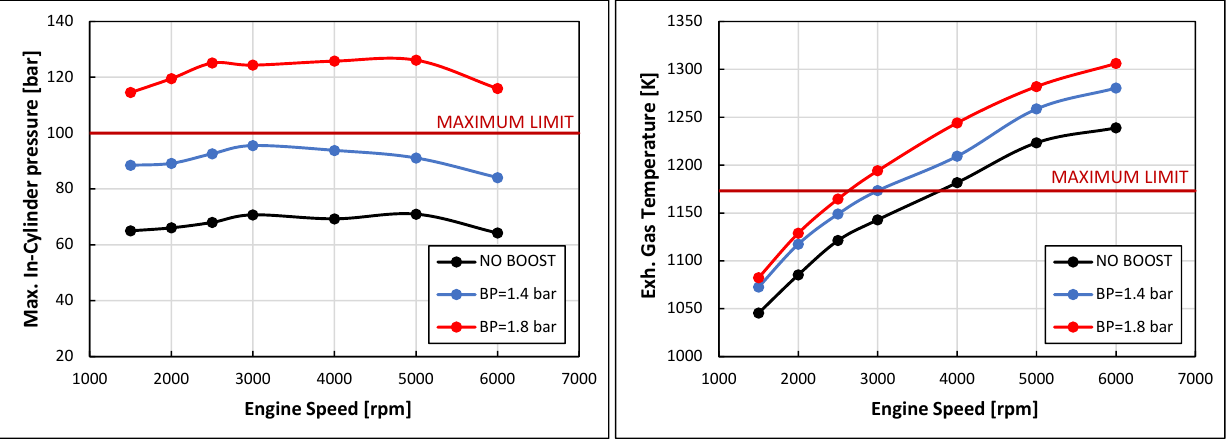
Figure 10. Maximum in-cylinder pressure ( left ) and exhaust gas temperature ( right ) for different boost levels. ϕ = 1. WOT.